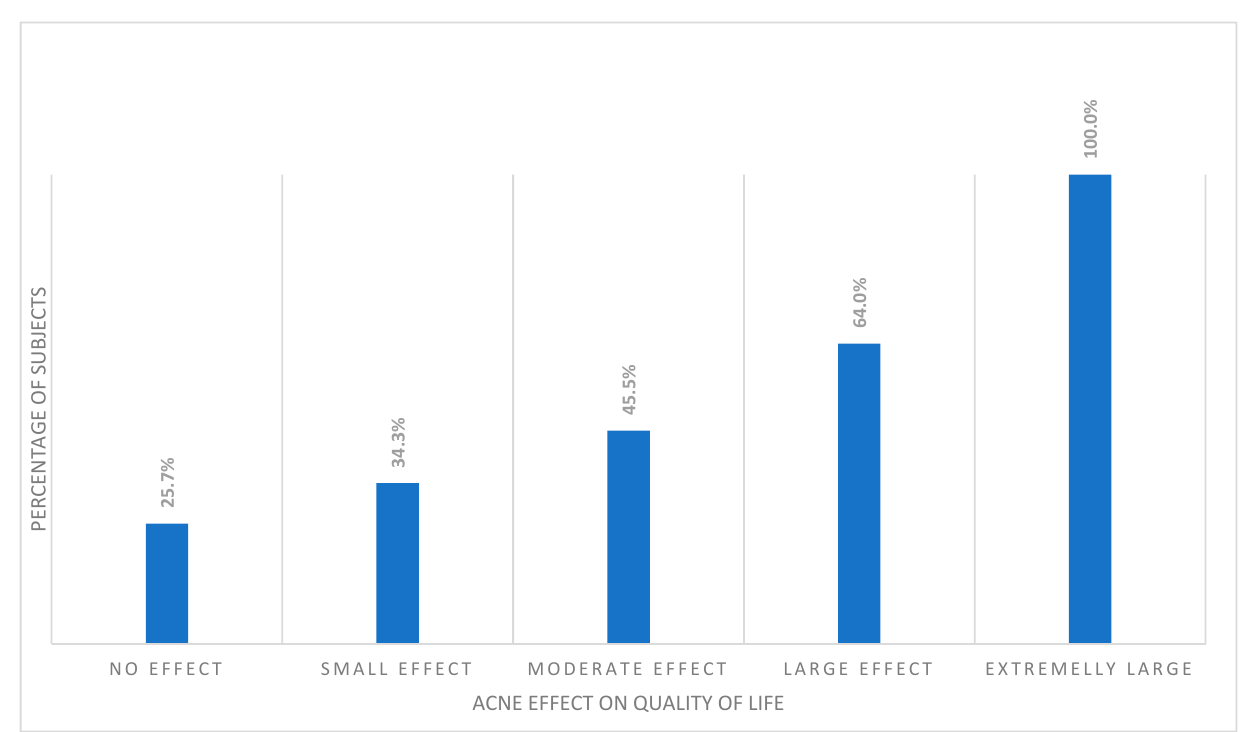
Figure 1. Percentage of alexithymic patients among different DLQI cut-offs.